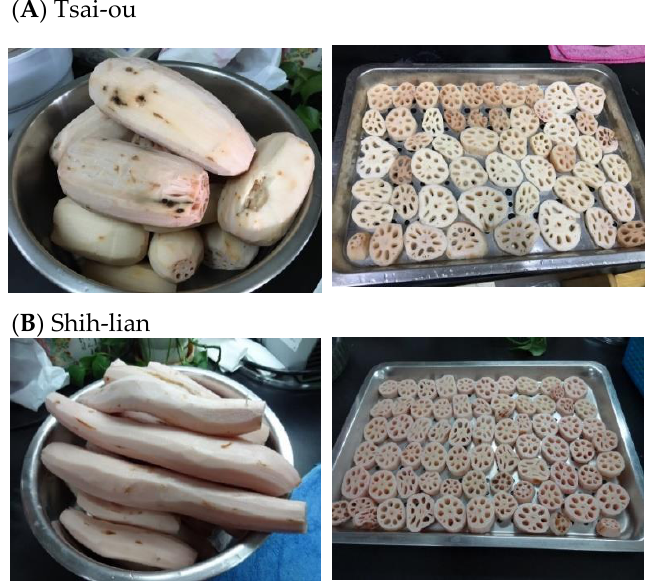
Figure 1. Photos of the two varieties of lotus rhizome ( Nelumbo nucifera Gaertn.) used in this study from Baihe district, Tainan, Taiwan.